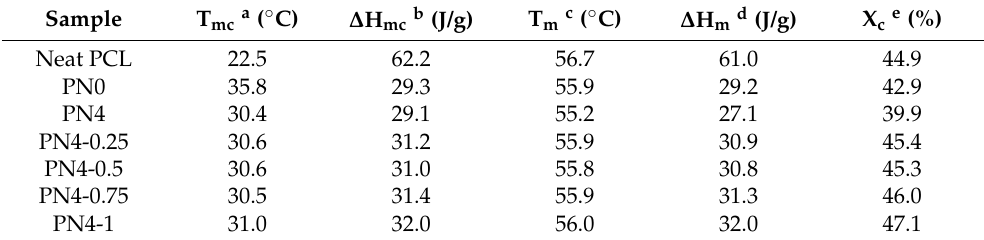
Table 3. DSC data of the PCL component derived from the DSC curves.